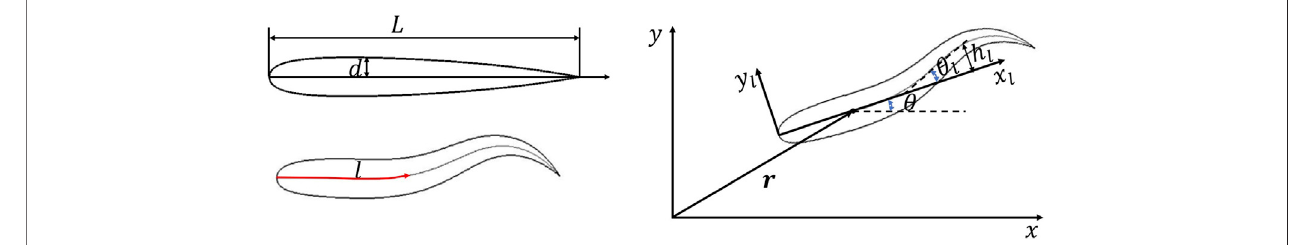
FIGURE 1 | A schematic illustration of the motion of the fi sh (Adapted from Ref.